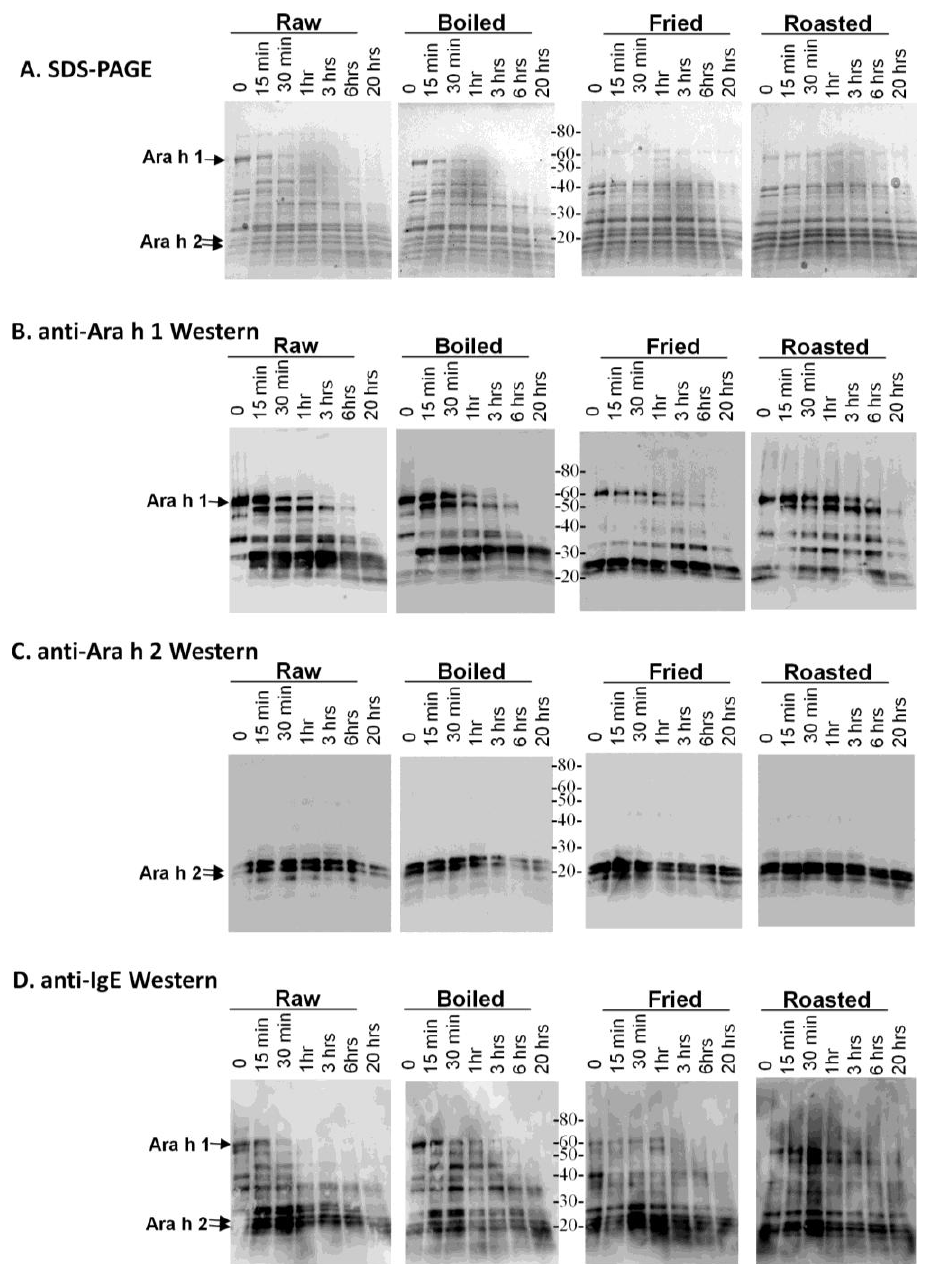
Figure 2. SDS-PAGE and western analysis of the digestion of raw, boiled, fried and roasted peanut extracts with pepsin. Soluble protein extracts from raw, boiled, fried and roasted peanuts were digested with pepsin and subjected to SDS-PAGE ( A ), western blot analysis with anti-Ara h 1 antibody ( B ), western blot analysis with anti-Ara h 2 antibody ( C ) and western blot analysis pooled human IgE sera from peanut allergic individuals ( D